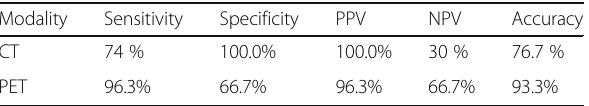
Table 4 The diagnostic value of FDG PET/CT and triphasic CT in post TACE